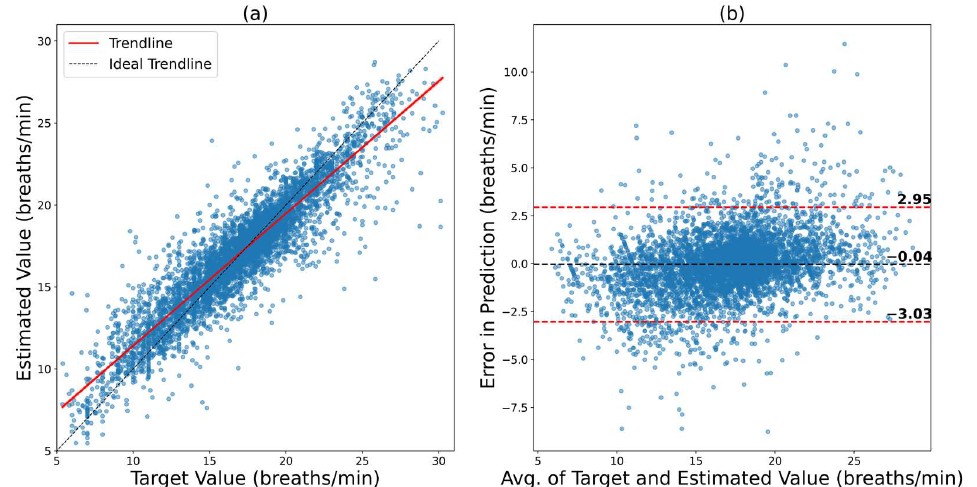
Figure 5. Results of ConvMixer on the combined dataset using fivefold cross-validation. ( a ) Regres- sion plot that shows how close the trendline is to the ideal trendline. ( b ) Bland–Altman plot that shows the 95% confidence interval of the error.